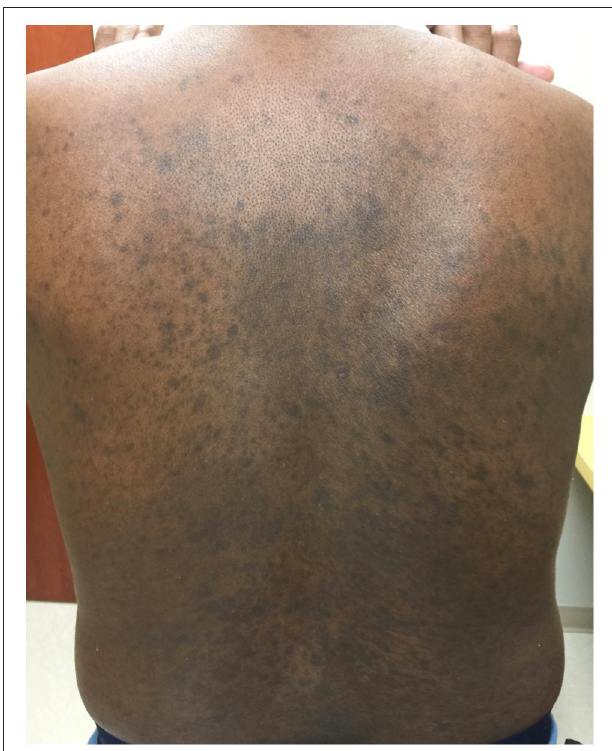
FIGURE 3 | Clinical image after successful treatment with NBUVB. On the back, there were widespread and numerous hyperpigmented macules coalescing into patches. There was no erythema or